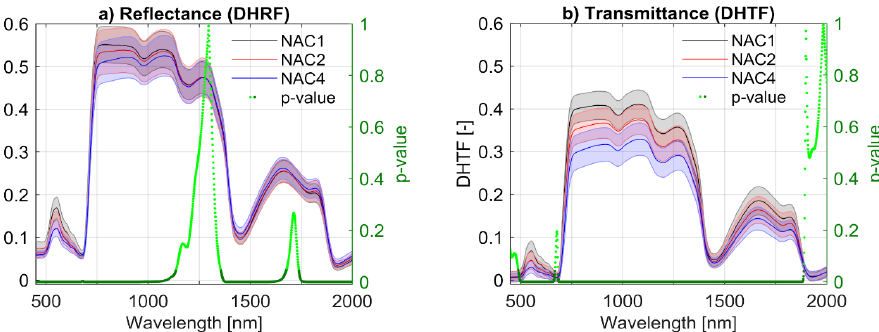
Figure 5. Needle optical properties averaged for ten GEOMON sites for current (NAC1), previous-year (NAC2) and older (NAC4) needles (left y-axis): ( a ) Directional-Hemispherical Reflectance Factor (DHRF); ( b ) directional-Hemispherical Transmittance Factor (DHTF). Solid line—average for all trees; shaded area—standard deviation; n = 123 per needle age class. Differences among needle age classes were tested by linear mixed-effect model. p -values (right y-axis) indicate significant (α = 0.05; dark green) and not significant (light green) differences between needle age classes for each wavelength.